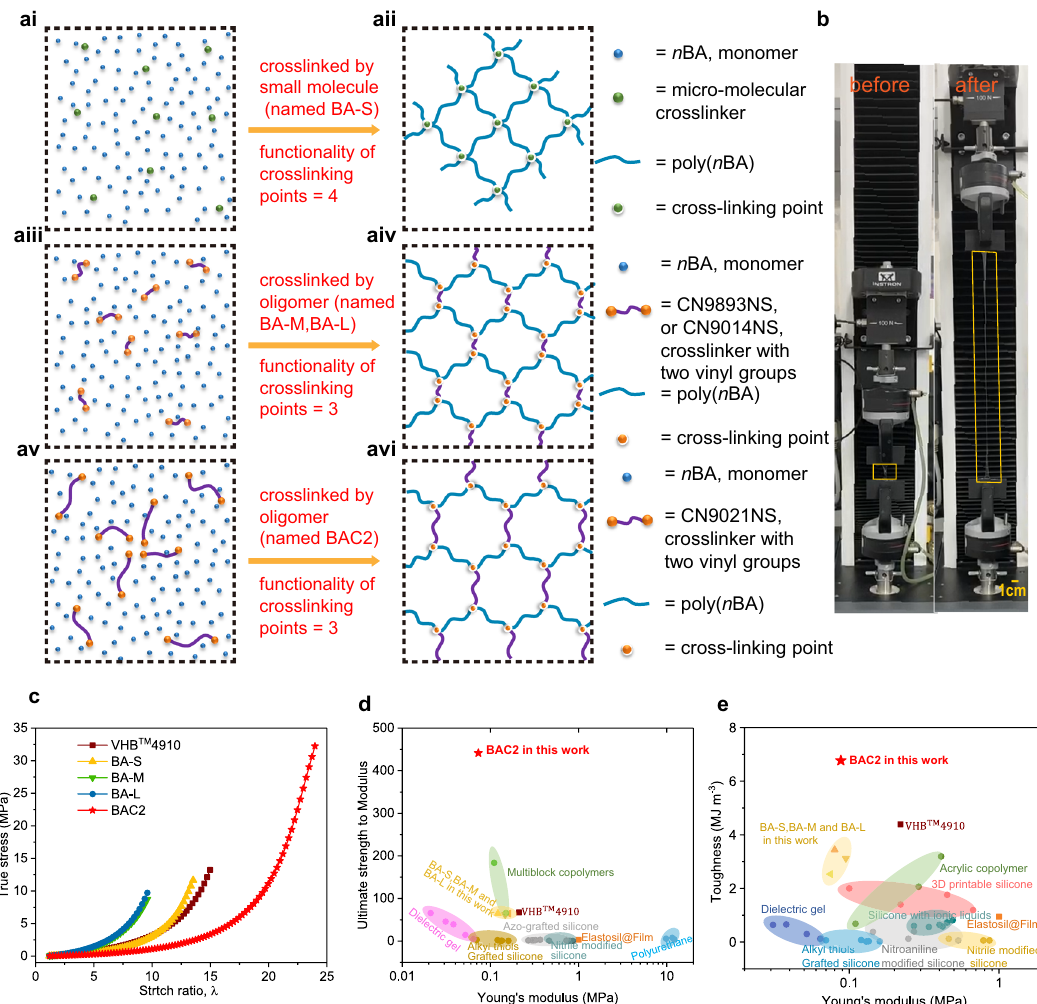
Fig. 1 Performance of uniform hybrid polymer network. a The precursor ( ai , aiii , av ) consists of n -butyl acrylate ( n BA) as monomers and small-molecules ( ai ) or oligomers with two vinyl groups ( – CH = CH 2 ) ( aiii and av ) as crosslinkers. When exposed to ultraviolet light (UV-light), the precursoris cured to a fl exible network ( aii , named BA-S; aiv , named BA-M or BA-L; avi , named BAC2). Distribution of molecular weight for those oligomers have been tested by gel permeation chromatography (GPC) and shown in Supplementary Table 1. b Comparison of BAC2 before (left) and after (right) uniaxial stretched. c The stress – strain curves of commercial VHB TM 4910 and BA-S, BA-M, BA-L, BAC2 at a stretch rate of 200 mm min − 1 . d Comparison of ultimate strength to modulus among VHB TM 4910, BA-S, BA-M, BA-L, BAC2, dielectric gel 37 , multiblock copolymers 33 , azo-grafted silicone 28 , nitroaniline modi fi ed silicone 18 , polyurethane 19 , alkyl thiols grafted silicone 16 and commercial Elastosil@Film 16 . e , Toughness plotted against Young ’ s modulus for VHB TM 4910, BA-S, BA- M, BA-L, BAC2, dielectric gel 37 , silicones with ionic liquids 17 , acrylic copolymer 25 , nitroaniline modi fi ed silicone 18 , nitrile modi fi ed silicone 39 , alkyl thiols grafted silicone 16 , 3D printable silicone 40 , and commercial Elastosil@Film 16 (Supplementary